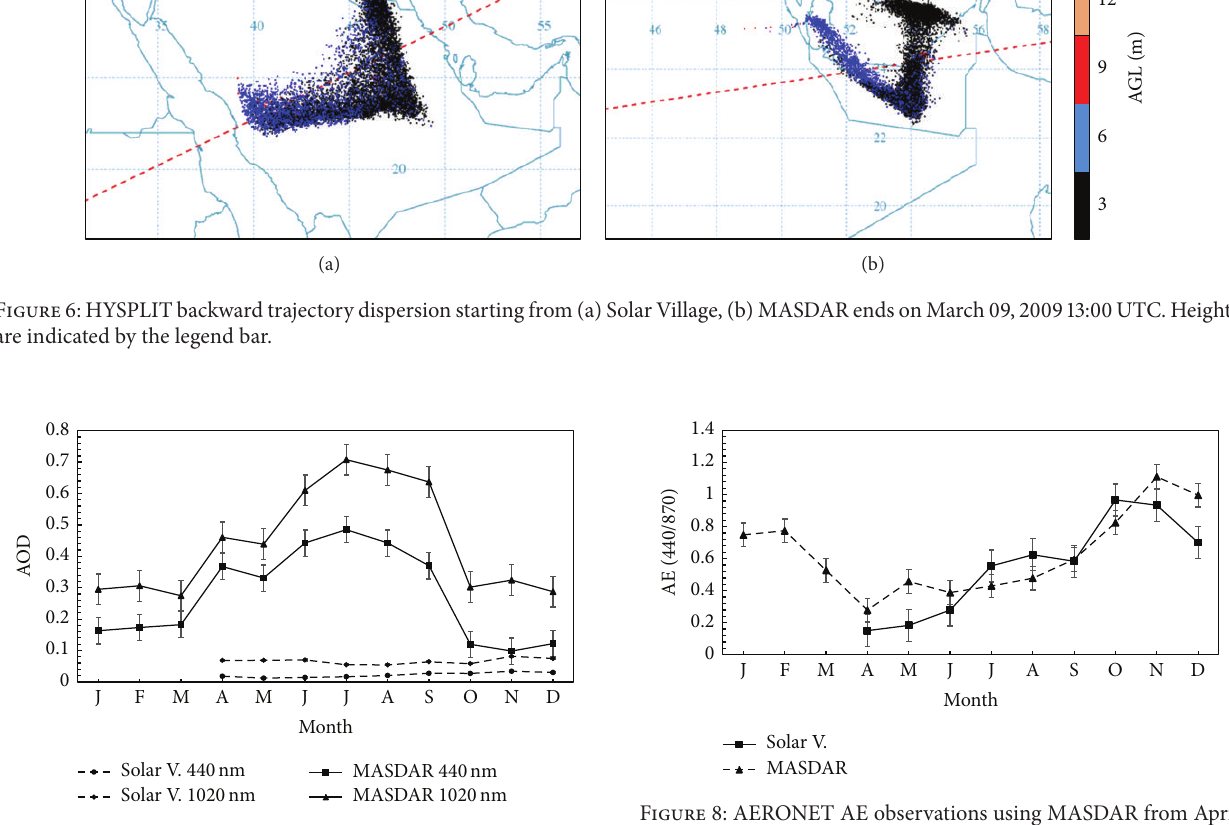
Figure 7: AERONET AOD observations at 440 and 1020 nm from April 2012 to May 2013 using Solar Village and MASDAR stations. The vertical bars represent standard errors.